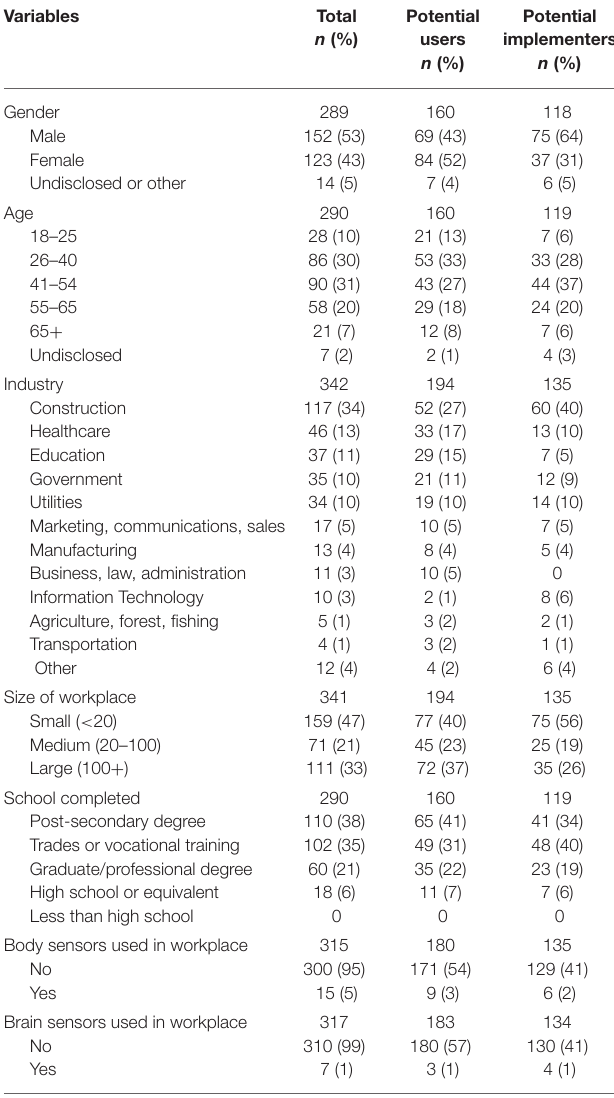
TABLE 1 | Summary of survey variables by sensor users and sensor